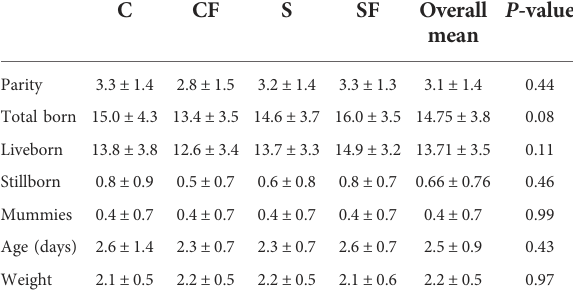
TABLE 3 Mean±SD. Descriptive statistics per variable at enrollment for C, CF, S and SF groups. Tukey ’ s Studentized Range (HSD) with α